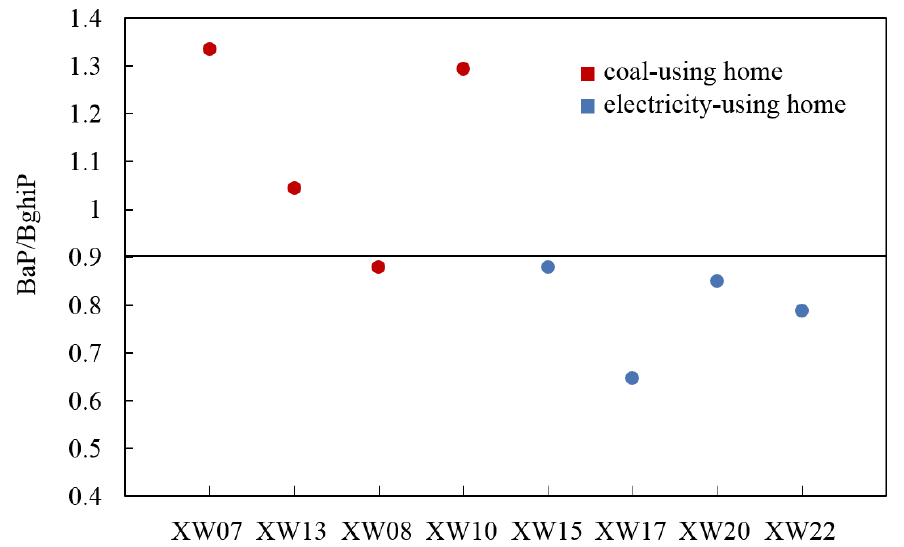
Figure 4. The BaP/BghiP ratios of samples collected from the homes in the Hutou village of the Laibin town, Xuanwei